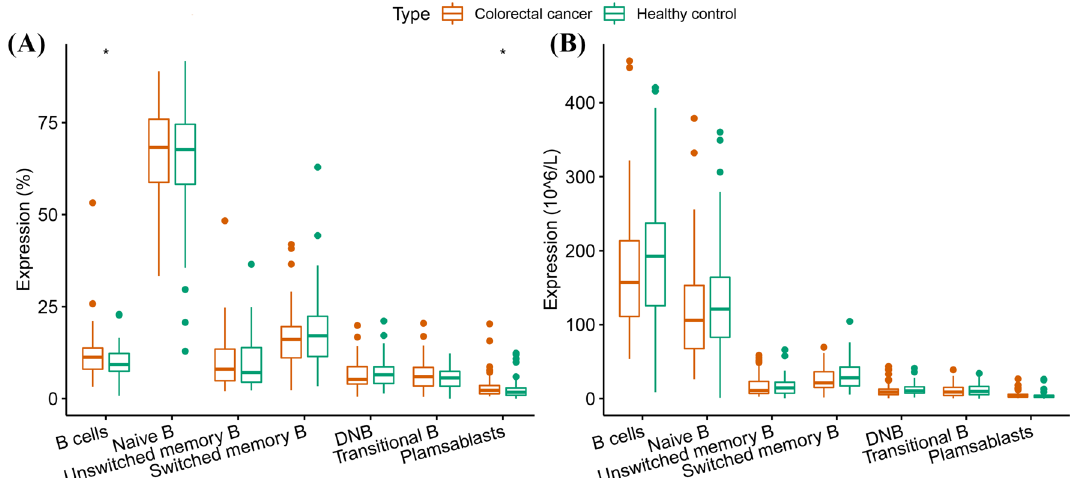
Figure 2. Differences in B lymphocyte subsets between the healthy control and CRC groups. ( A ) Proportions of B lymphocyte subsets. ( B ) Absolute counts of B lymphocyte